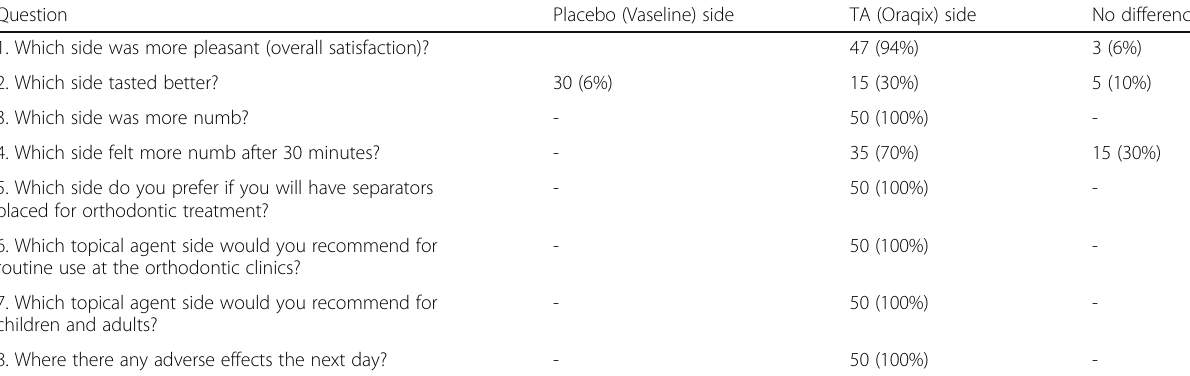
Table 3 The questionnaire comprising of eight questions set for the subjects to answer after completion of the study Question Placebo (Vaseline)